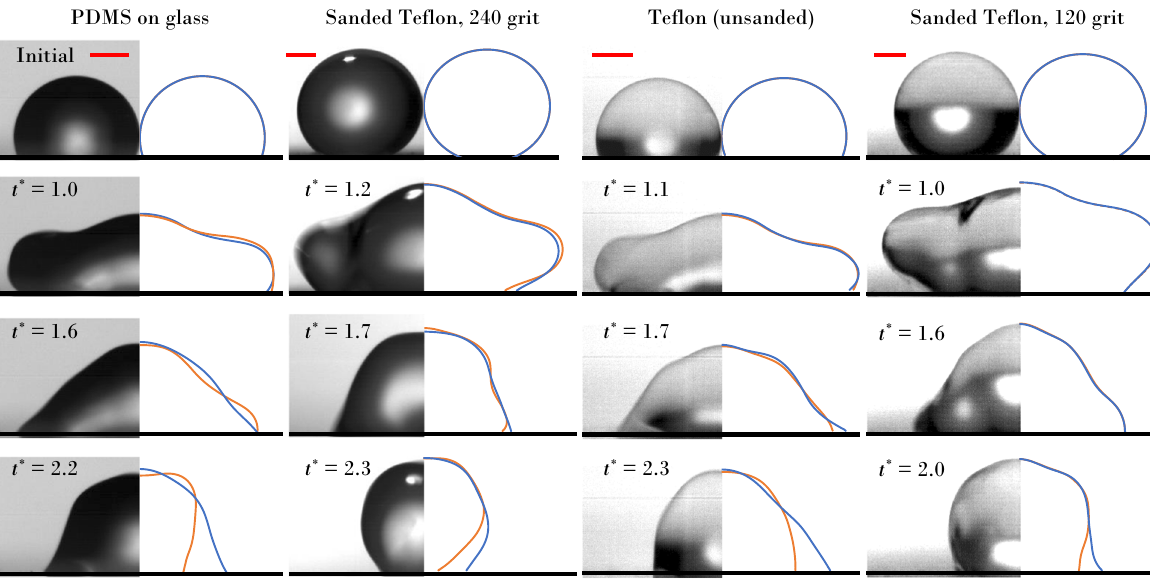
Fig. 5 Comparison of side-view coalescence dynamics ( x - z plane) contrasting experiments (left) with simulations (right). The Davis – Hocking model is shown in blue line type and the Kistler model in orange line type. Scale bar (red line) is 0.5 mm in all